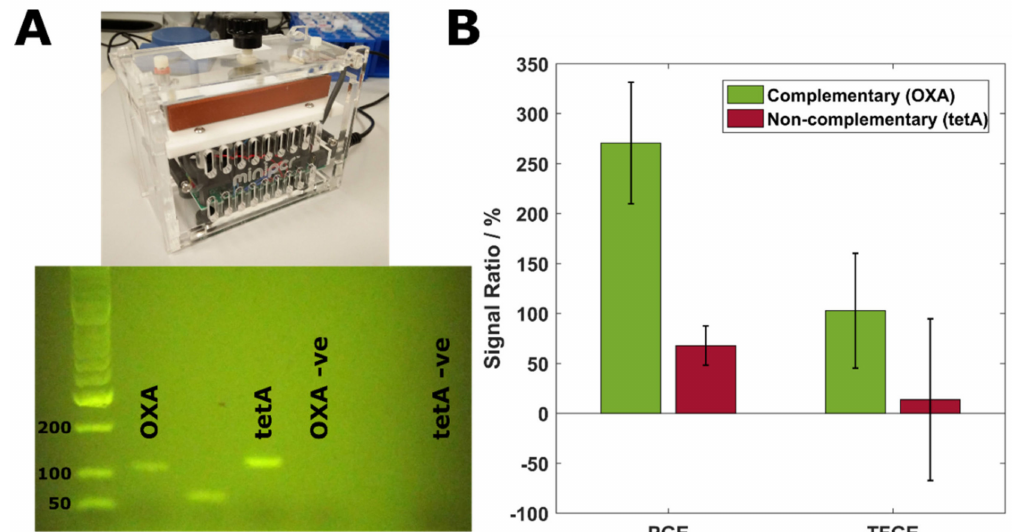
Figure 5. ( A ) Benchtop PCR thermocycler and gel electrophoresis results of complementary and non-complementary target amplification. –ve columns show amplification of a no-template control containing primers for the respective gene. ( B ) PGE and TFGE responses to the addition of complementary and non-complementary DNA target to electrode surface. Error bars indicate standard deviation, n =